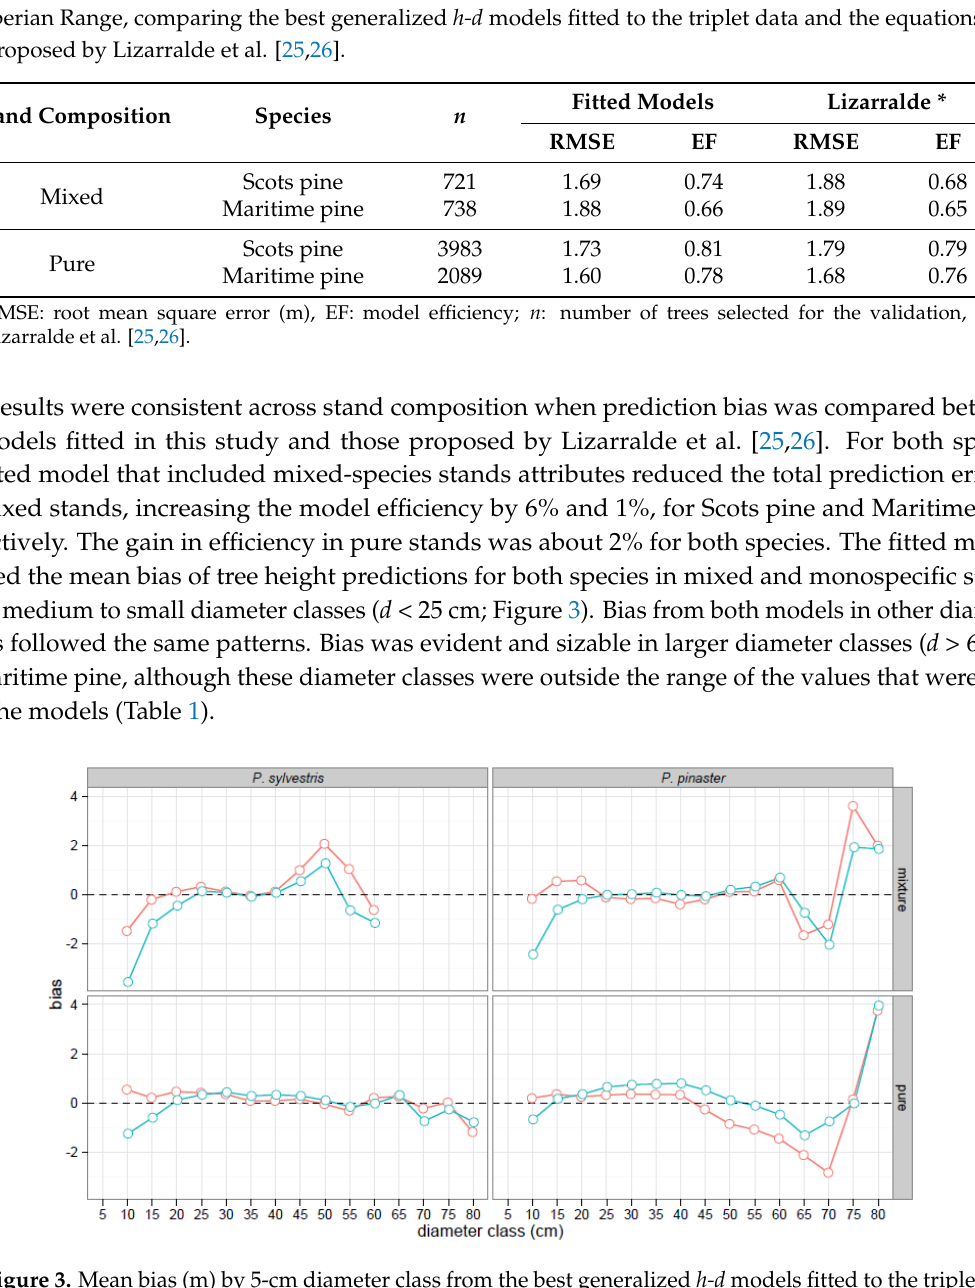
Figure 3. Mean bias (m) by 5-cm diameter class from the best generalized h-d models fitted to the triplet data (red circles and lines) and from the Lizarralde et al. [25,26] h-d functions (blue circles and lines).